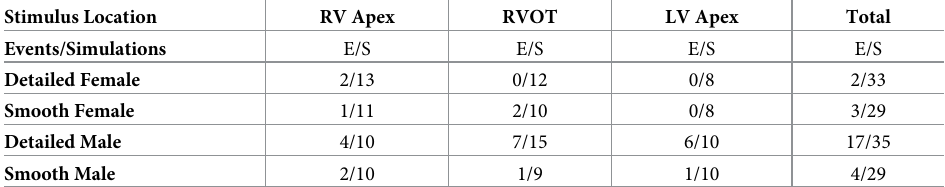
Table 4. Arrhythmic events including reentries and sustained VTs. The number of events (E) are shown along with the total number of simulations (S) for each programmed stimulus protocol at each location. Stimulus Location RV Apex